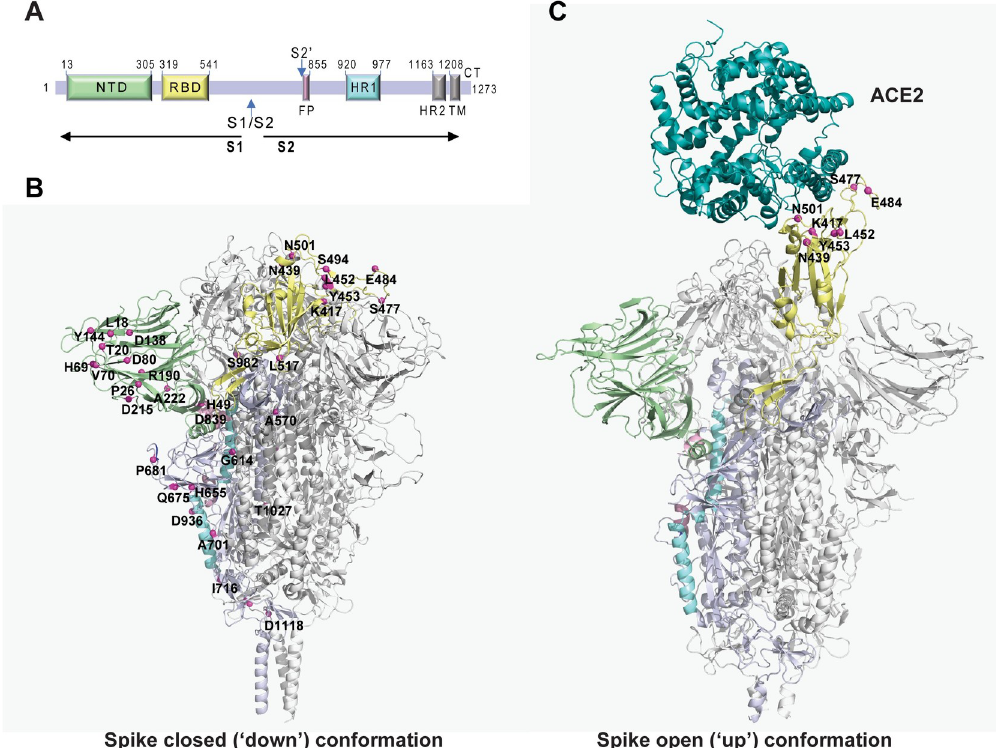
Fig 1. Location of the mutations in spike tested in this work. (A) Schematic representation of the SARS-CoV-2 spike primary structure. NTD, N-terminal domain; RBD, receptor-binding domain; S1/S2, S1/S2 protease cleavage site; S2’, S2’ protease cleavage site; FP, fusion peptide; HR1, heptad repeat 1; HR2, heptad repeat 2; TM, transmembrane domain; CT, cytoplasmic tail. The protease cleavage sites are indicated by arrows. (B) The mutations in spike engineered in this study are mapped onto the spike protein surface, using a structure obtained by homology-based modelling with the structure PDB ID 6XR8 as a template. Mutations are highlighted using magenta spheres mapped on one of the monomers, which is represented with different colors to highlight important regions: NTD (green), RBD (yellow), FP (pink), HR1 (cyan). The remaining monomers are displayed in grey. (C) The structure of the spike protein with one RBD up and bound to ACE2 (PDB ID 7DF4) is shown to highlight the mutations used in this study located in the RBD in the context of its interaction with the receptor. The spike protein is represented in the same color scheme used in (B) and ACE2 is displayed in teal.